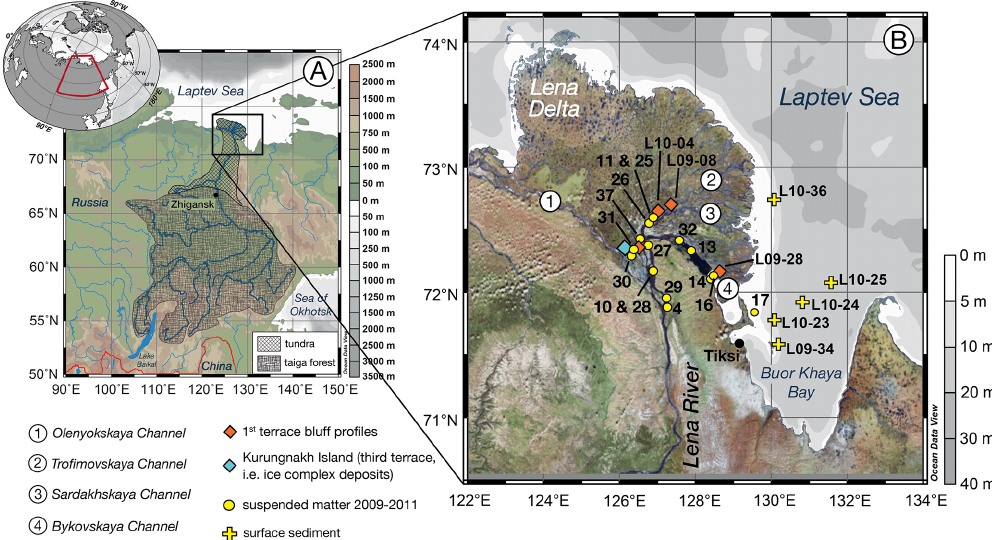
Figure 1. (a) Lena River catchment area with approximate tundra and taiga forest distribution; (b) Lena Delta and Buor Khaya Bay sampling sites from 2009 to 2011 and associated sample